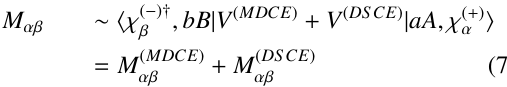
pp π − π − scattering pro- → B , is accompa- →